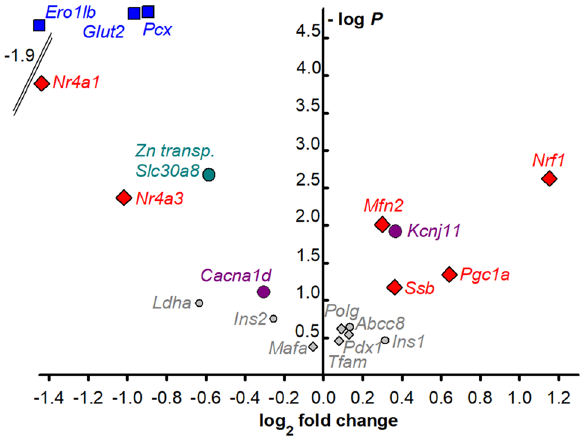
Figure 7. Change in selected transcripts upon Nkx6.1 ablation—a volcano plot shows increased ( right ) and decreased ( left ) transcripts of selected genes as indicated on a log2 scale, while the z-axis shows the probability of such changes (statistical significance of the assay evaluated by Student’s T-tests). Grouped data for lines a and b of INS-1E Nkx6.1 – / – cell are compared to INS-1E scrl/scrl